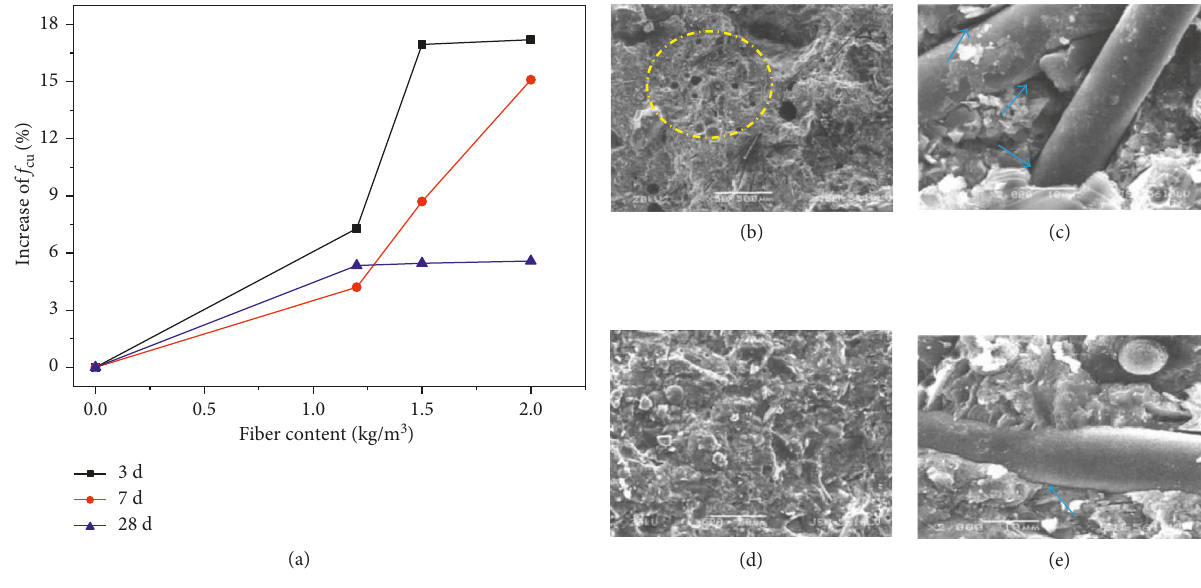
F IGURE 6: The effect of the pretreatment of BF on BFRC: (a) the change of the cubic compressive strength ( f content, (b) the section of matrix without pretreatment, (c) the interface between BF and matrix without pretreatment, (d) the section of matrix with pretreatment, and (e) the interface between BF and matrix with pretreatment